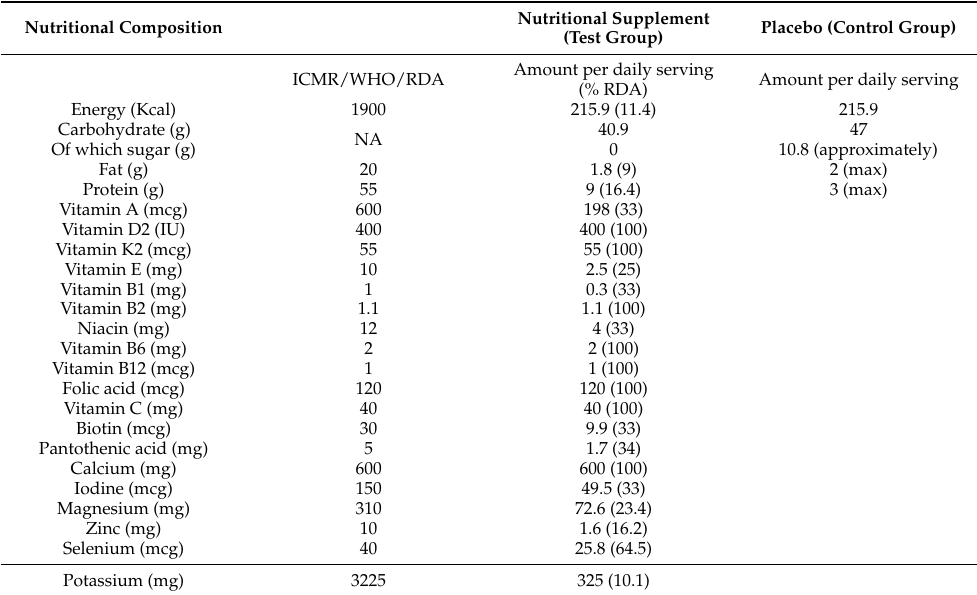
Table 1. Composition of supplements. ICMR: Indian Council of Medical Research; RDA 2010: Recommended dietary allowances; WHO 2004: World Health Organisation; Kcal: kilocalorie. Nutritional Composition Nutritional Supplement (Test Group) Placebo (Control